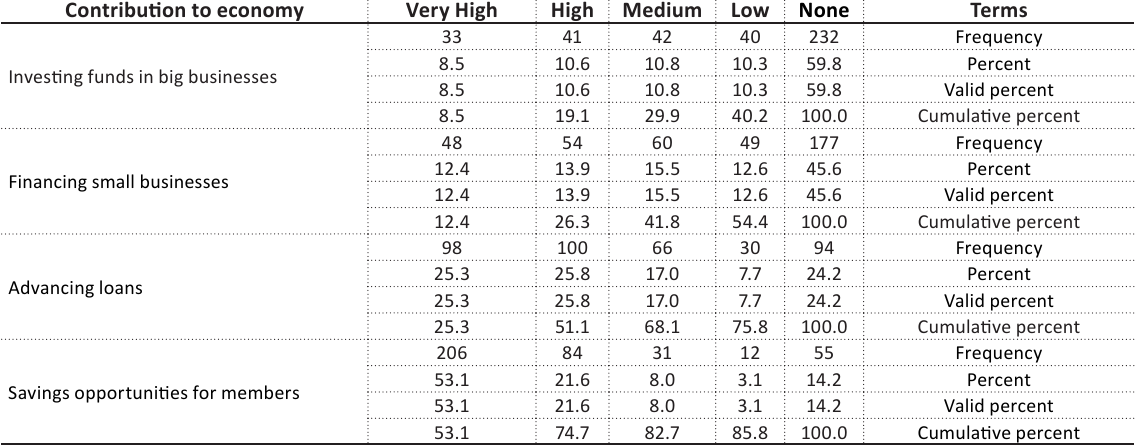
Table 8. Responses on how stokvels contribute to the economy Contribution to